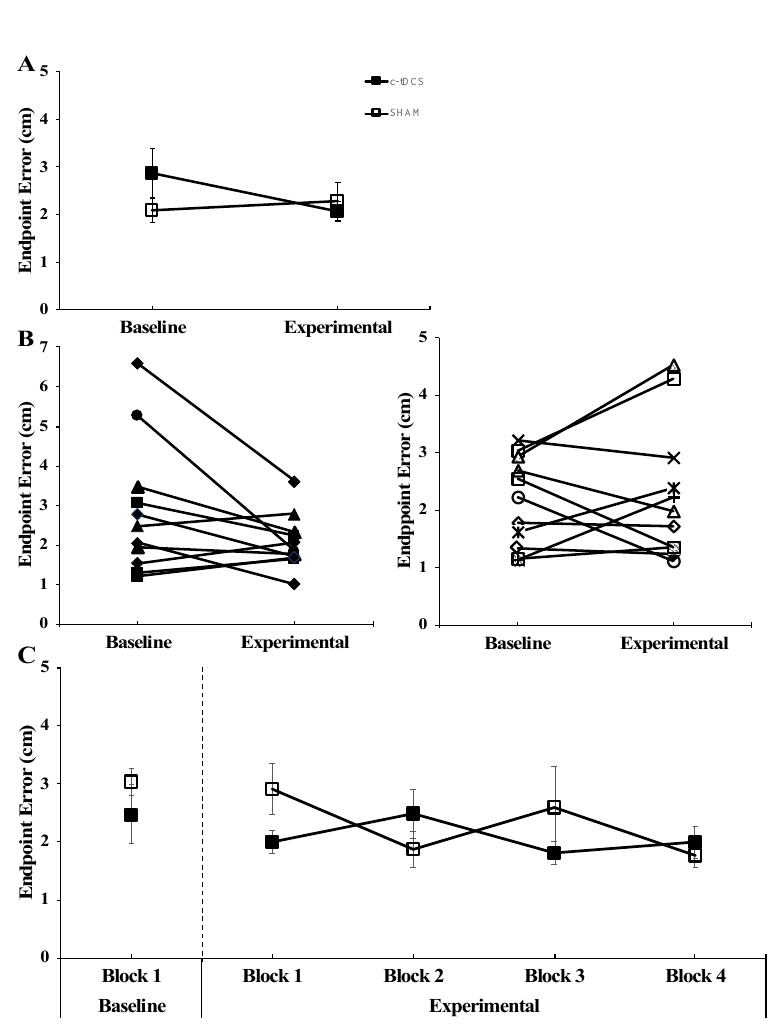
Figure 4. Endpoint error in the arm movement task (AMT) for the cerebellar transcranial direct current stimulation (c-tDCS) (closed squares) and SHAM groups (open squares) in the Baseline and Experimental conditions. ( A ) The endpoint error was not significantly different between c-tDCS and SHAM groups ( p = 0.561) or for the Baseline and Experimental conditions ( p = 0.164). ( B ) Individual endpoint error data corresponding to the data in Panel (A) for the 11 participants in the c-tDCS group and 11 participants in the SHAM group. ( C ) For illustrative purposes, the individual AMT trial blocks corresponding to the average data presented in Panel (A) are depicted. It can be seen that there is no trend for endpoint error to improve with trial block number to a greater extent in the c-tDCS group compared with the SHAM group due to the accumulating stimulation time. Similarly, for average movement velocity in the AMT, the group × condition interaction was not statistically significant (F (1,20) = 0.072, p = 0.791, η 2 = 0.004). Finally, the main e ff ect for group (F (1,20) = 0.000, p = 0.994, η 2 = 0.000) and main e ff ect for condition (F (1,20) = 2.443, p = 0.134, η 2 = 0.109) were both non-statistically significant (Figure